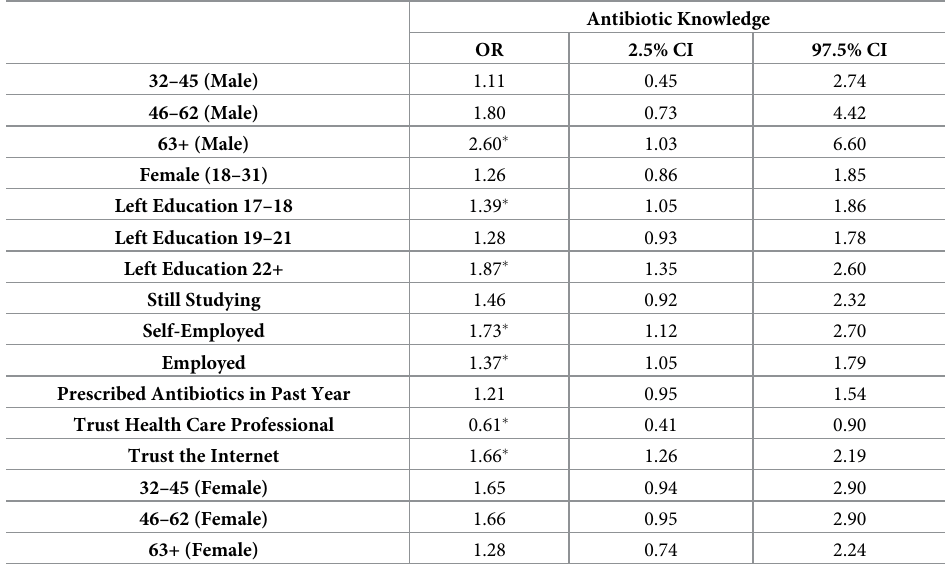
Table 5. Ordinal regression analysis of eurobarometer knowledge